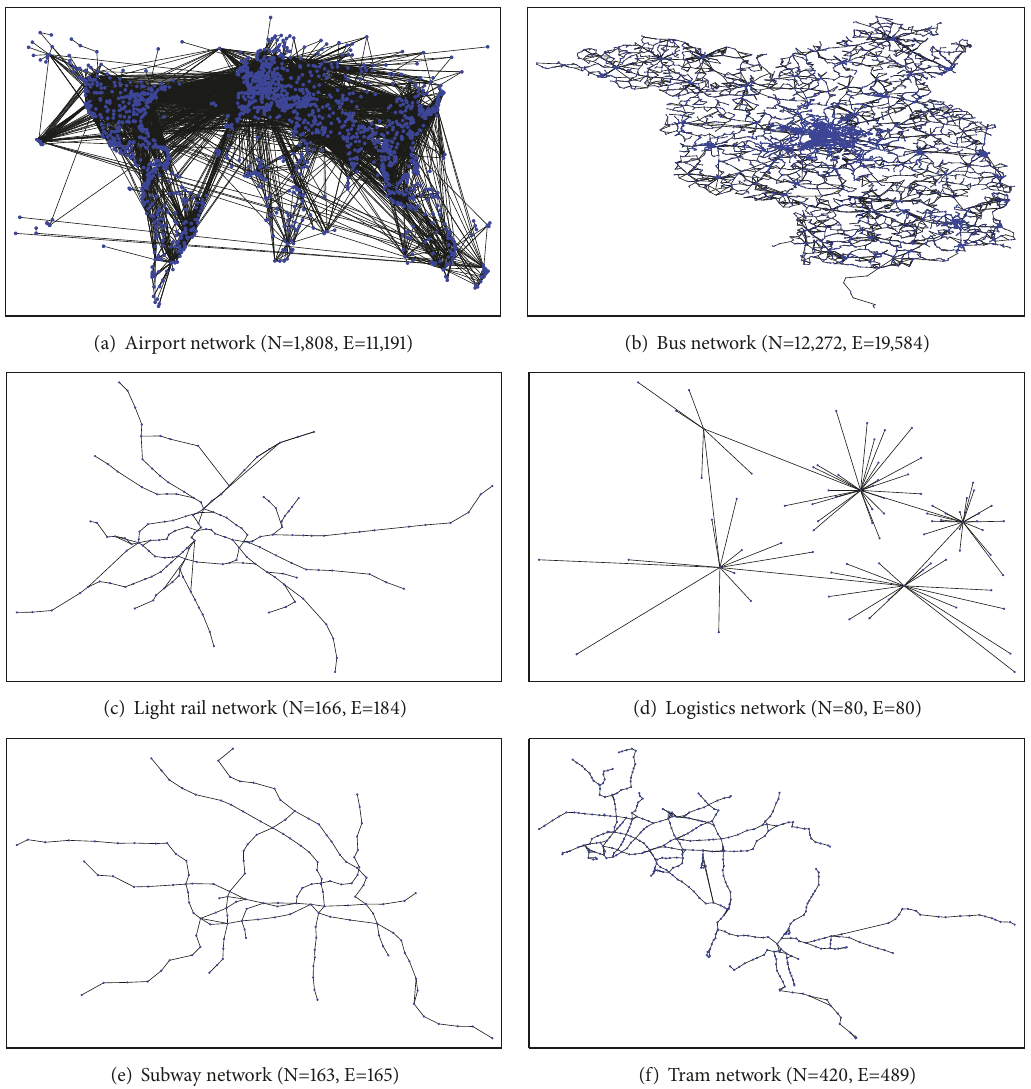
Figure 9: Graphical representations of the six transportation networks considered in this study, including both node-based (airport and logistics) and link-based networks (bus, light rail, subway, and